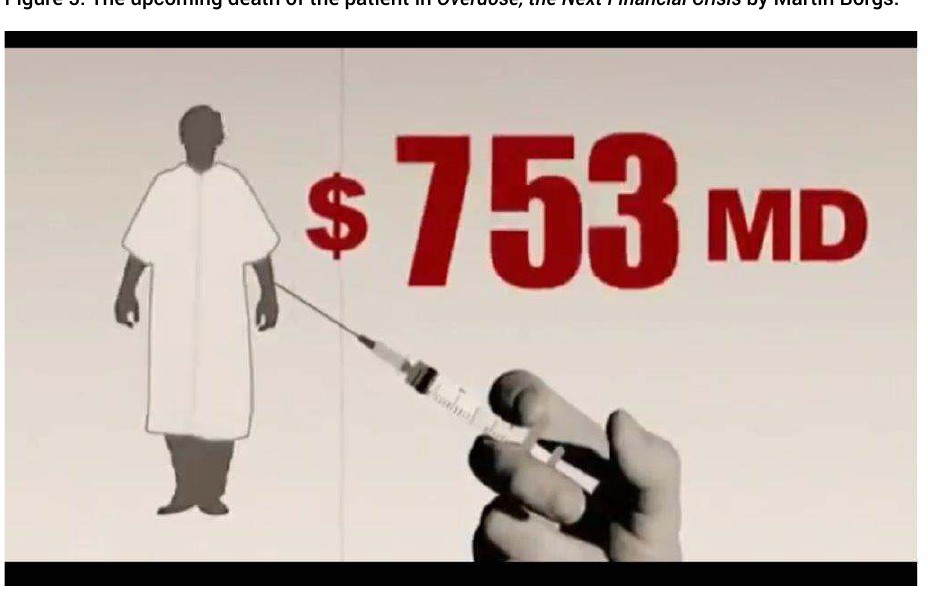
Figure 5: The upcoming death of the patient in Overdose, the Next Financial Crisis by Martin Borgs.